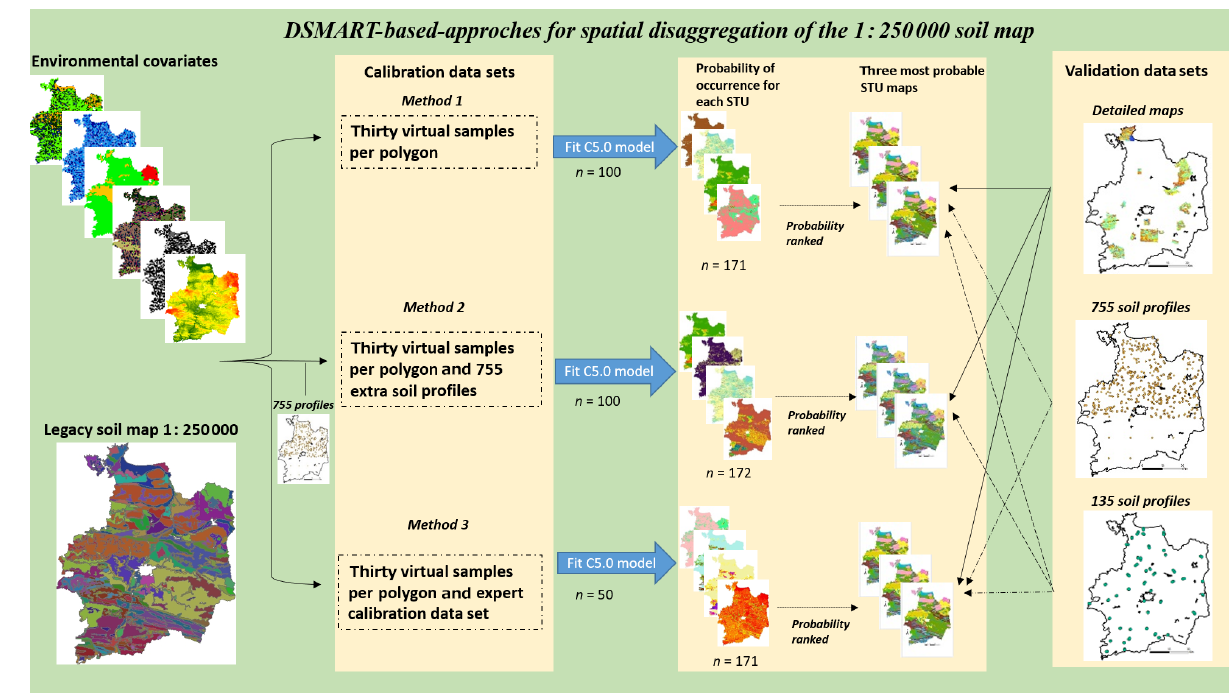
Figure 2. Schematic of the DSMART-based approaches algorithm. The steps in DSMART are as follows: method 1 – construct the calibration data set; method 2 – train the C5.0 model; and method 3 – estimate the STU maps and their associated probabilities of